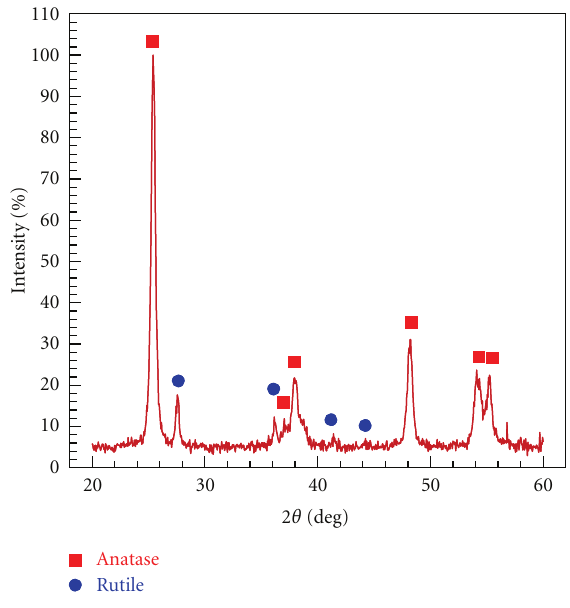
Figure 2: XRD patterns of TiO 2 nanoparticles.